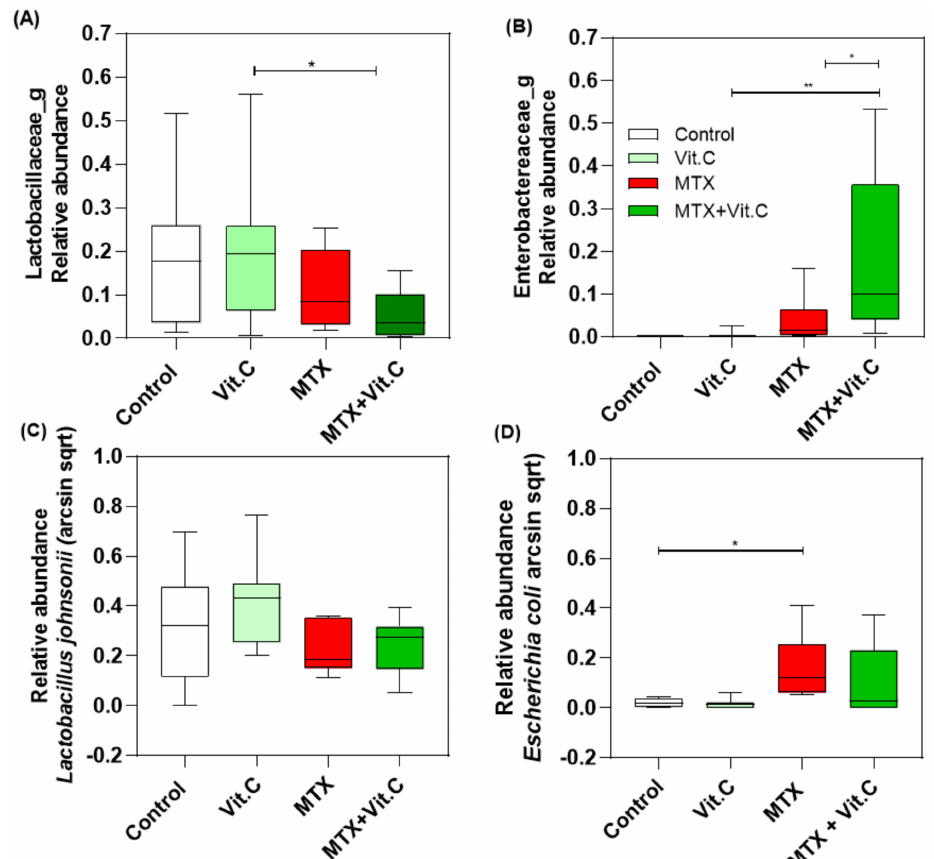
Figure 7. Relative abundance between healthy controls and MTX-treated and MTX and Vitamin C-treated rats at day 4 after MTX insult. Relative abundance of Lactobaciliaceae ( A ), Enterobacteriaceae ( B ), Lactobacillus johnsonii ( C ) and Escherichia coli ( D ). Relative abundance of Lactobacillus johnsonii and Escherichia coli were calculated as arcsin sqrt. * ( p < 0.05) and ** ( p < 0.01) represent the significant changes in the relative abundance between the different